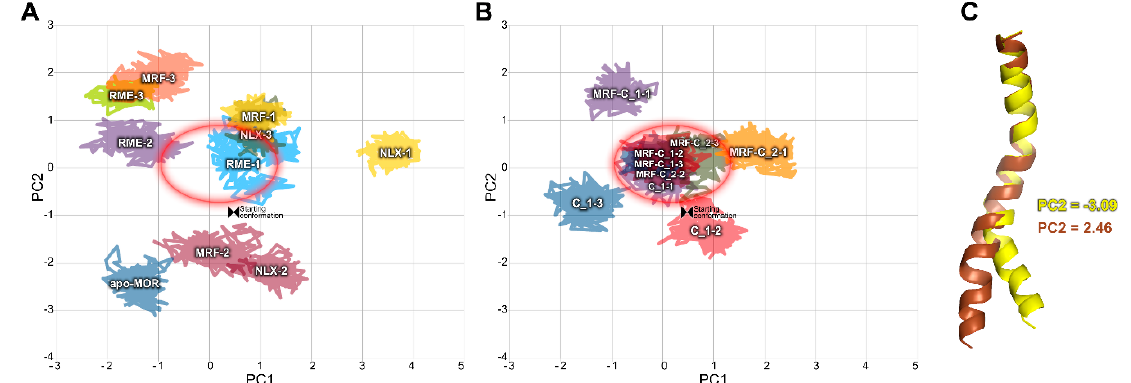
Figure 8. PCA of TM6. ( A , B ) Conformational space occupied by investigated complexes through last 50 ns of simulations in a common space. The data were split in two panels for clarity. The red ellipse is added to facilitate comparisons. ( C ) Projections of extreme PC2 values on the trajectories. Color-coding of the legend corresponds to colors of the frames.